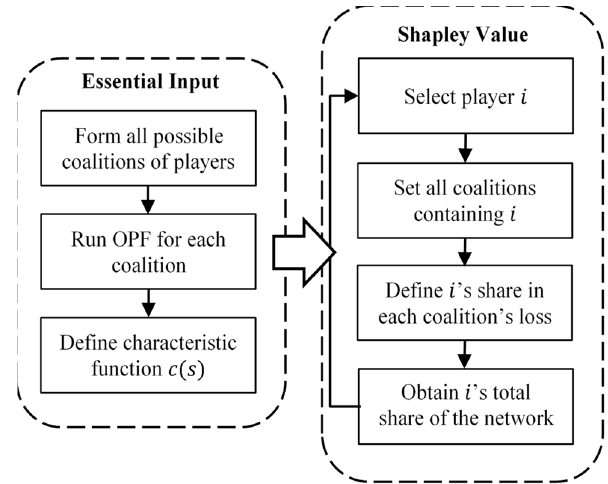
Figure 1. The proposed game-theoretic algorithm for loss allocation in power distribution systems.